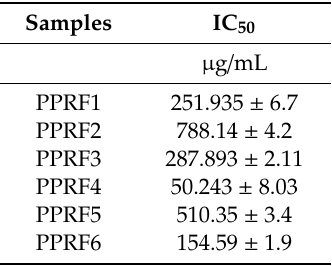
Table 3. Hepatoprotective effects of different polyphenolic fractions of L. tetragona.